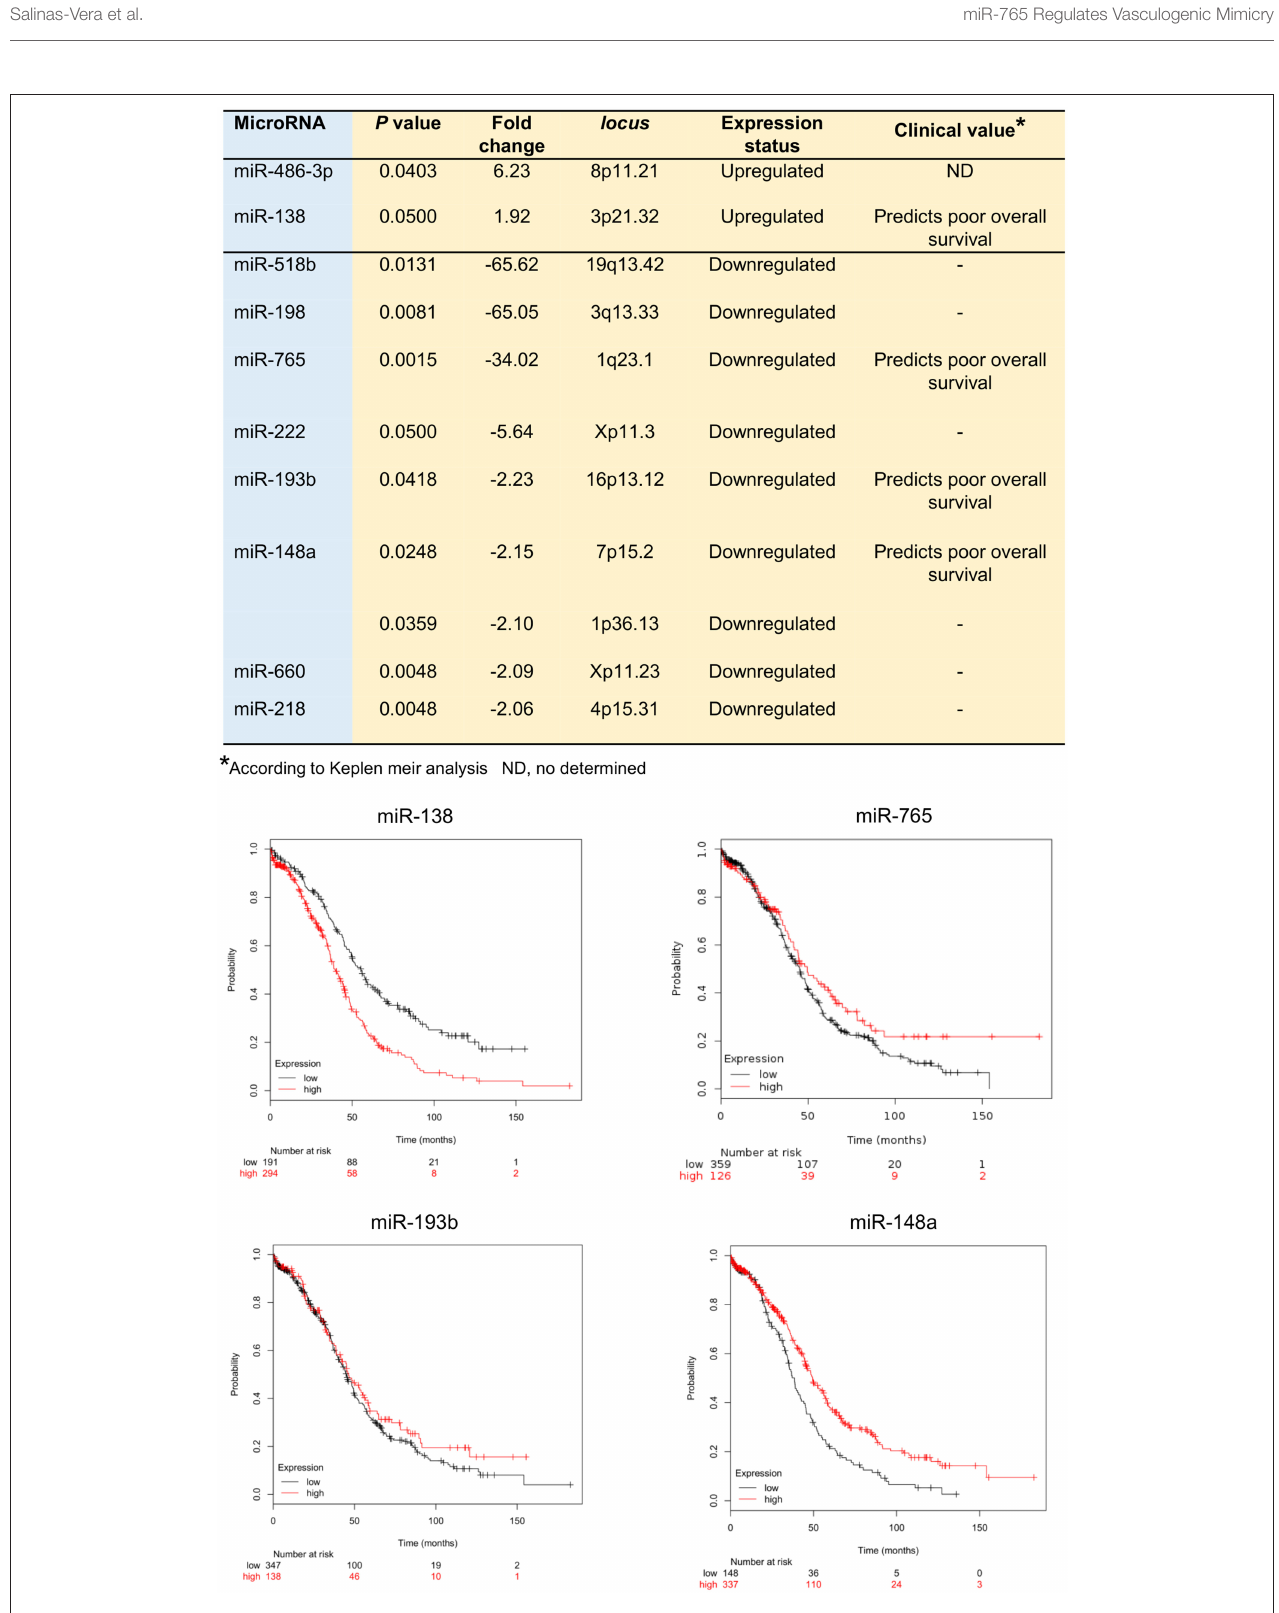
FIGURE 2 | MicroRNAs deregulated in SKOV3 cells after 48h hypoxia. Upper Table illustrate the hypoxamiRs regulated in SKOV3 cells. The miRNAs expression status and clinical value predicted after Kaplan Meir analysis is depicted. Bottom Images showed the Kaplan Meir plots for four hypoxamiRs with potential clinical value using Start miRpower for pan-cancer as implemented in the KM plotter online tool (http://kmplot.com/analysis/index.php?p=backgroundr).